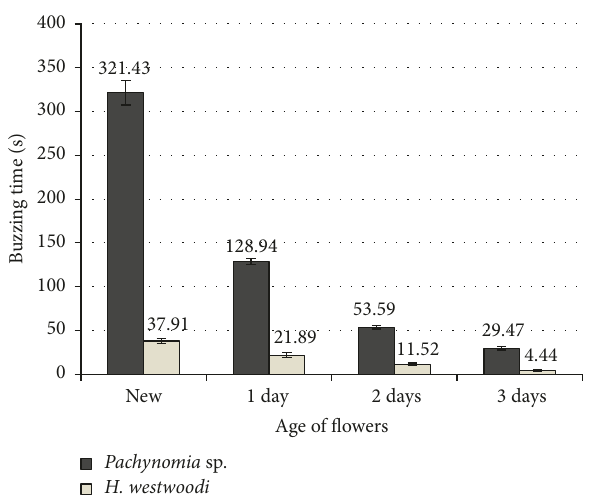
Figure 3: Comparison of buzzing times of Pachynomia sp. and H. westwoodi bees at S. melongena flowers of the four age groups (new, 1-day-old, 2-day-old, and 3-day-old